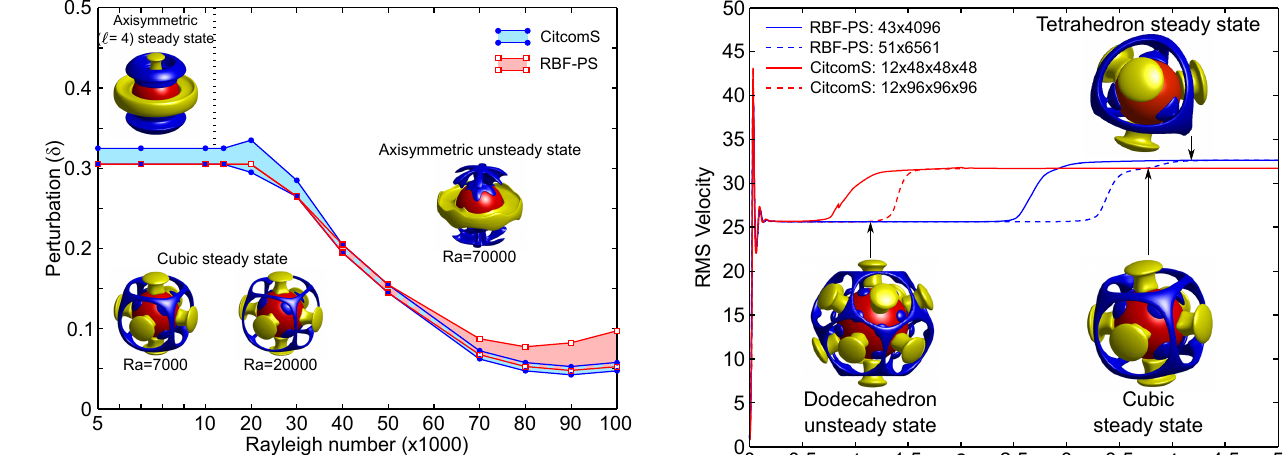
Figure 6. Stability domain of the cubic steady-state pattern as a function of the perturbation to the initial condition, δ , and the Rayleigh number. Shaded areas show the transitional domains for the CitcomS (blue) and RBF-PS (red) methods. Detailed patterns are presented in Fig. 2 for 5000 ≤ Ra ≤ 10000 and Fig. 4 for Ra = 70000. For each model, the bottom curve is the maximum δ value for which it converges to the cubic steady state, while the top curve is the minimum δ value which converges to an axisymmetric pattern (steady or unsteady). The black dotted line is the value of the Rayleigh number that marks the transition between the ‘ = 4 steady state and the unsteady state.